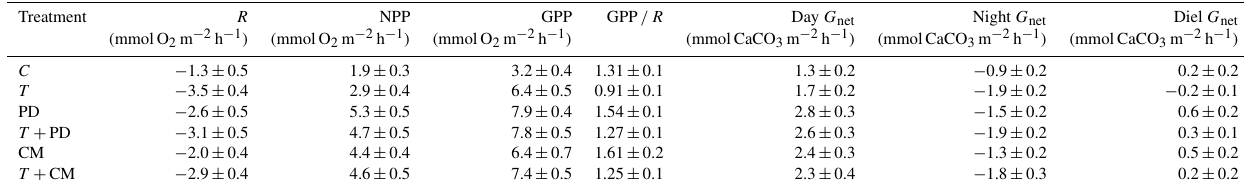
Table 3. Calculated respiration ( R : mmolO 2 m − 2 h − 1 ) , net primary productivity (NPP: mmolO 2 m − 2 h − 1 ) , gross primary productivity (GPP: mmolO 2 m − 2 h − 1 ) , the ratio of GPP /R , and net calcification ( G net : mmolCaCO 3 m − 2 h − 1 ) in the control and treatment chambers. Values correspond to the mean ± SD.